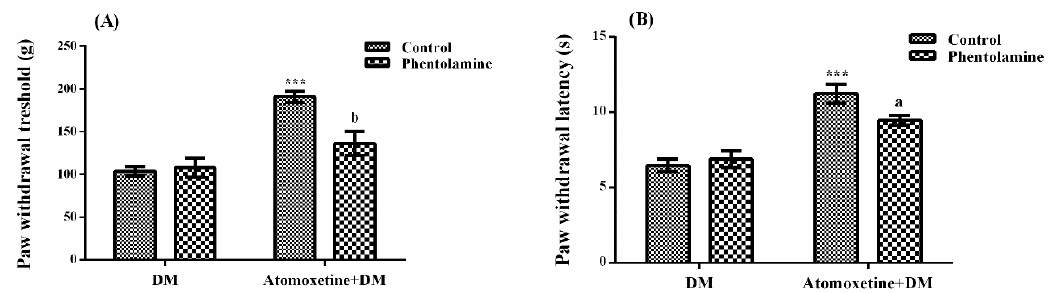
Figure 4. Effects of phentolamine pre-treatments on the antihyperalgesic responses induced by atomoxetine (3 mg/kg, 14 days) against mechanical ( A ) and thermal ( B ) nociceptive stimuli applied in the Randall-Selitto and Hargreaves tests, respectively. Values are given as mean ± S.E.M. Significant difference against physiological saline administrated diabetic group (DM) is *** p < 0.001; Significant difference against atomoxetine administrated diabetic groups (Atomoxetine+DM) are a p < 0.05 and b p < 0.01. Two-way repeated ANOVA, post hoc Bonferroni test, n = 8.